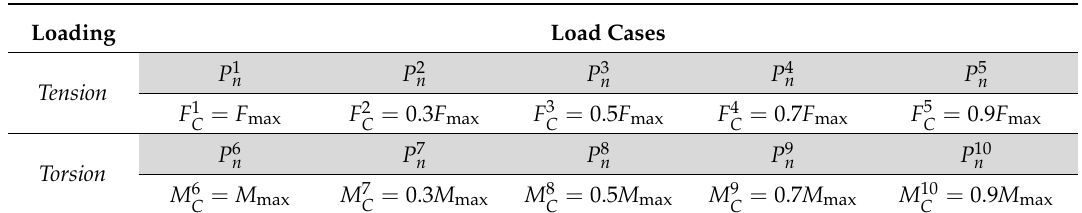
Table 3. Non-proportional loading cases used in the research.